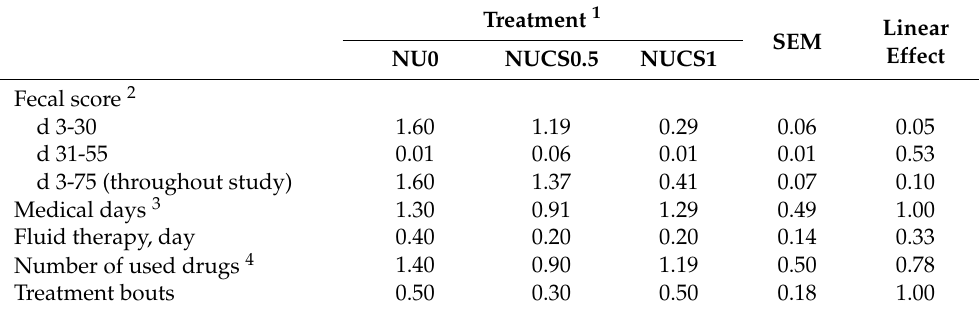
Table 3. Effects of nucleotide (NU) supplementation to whole milk on health of Holstein